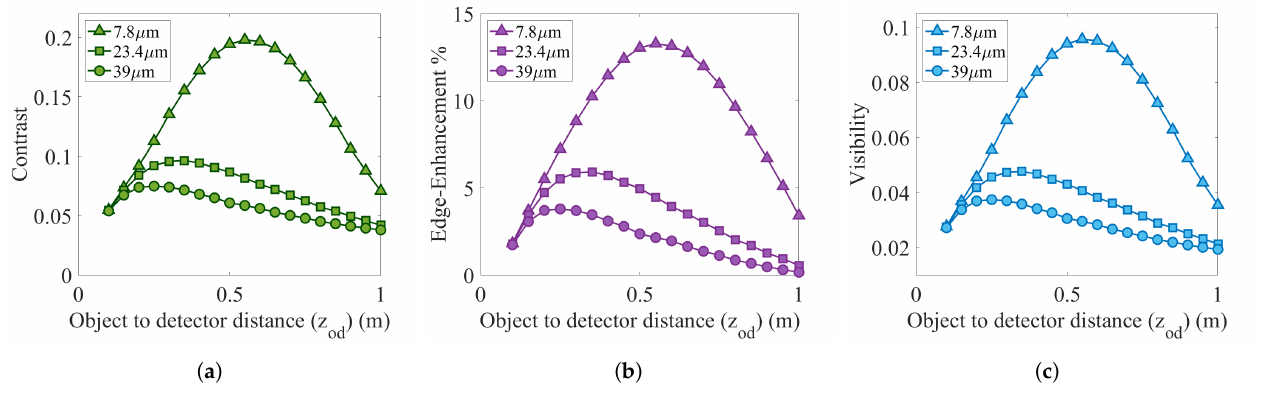
Figure 8. Simulation results of the behavior of contrast, edge-enhancement, and visibility of a PB-XPCi system versus the object-to-detector distance, carried out for a PEEK wire with 585 µ m in